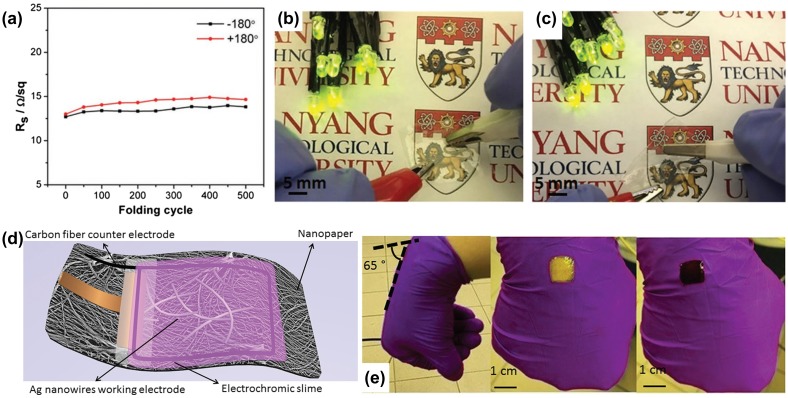
(a) Sheet resistance versus the number of ±180° folding cycles. Images of the foldability test of the SWCNT@Ag nanopaper electrode (b) before and (c) after crumpling. (d) Schematic of the solid state EC device. (e) Demonstration of solid state EC device mounted on a bent wrist [42]. Reproduced with the permission of [42]. Copyright 2016 Wiley-VCH.